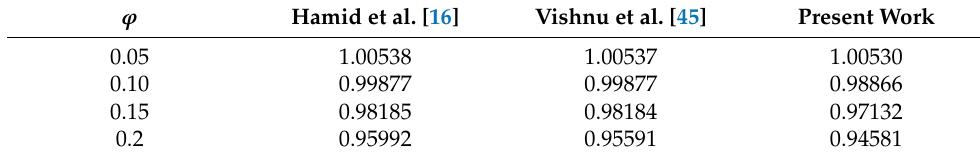
Table 4. Results comparison with earlier findings for Al 2 O 3 nanofluids. ϕ Hamid et al. [16] Vishnu et al. [45] Present Work